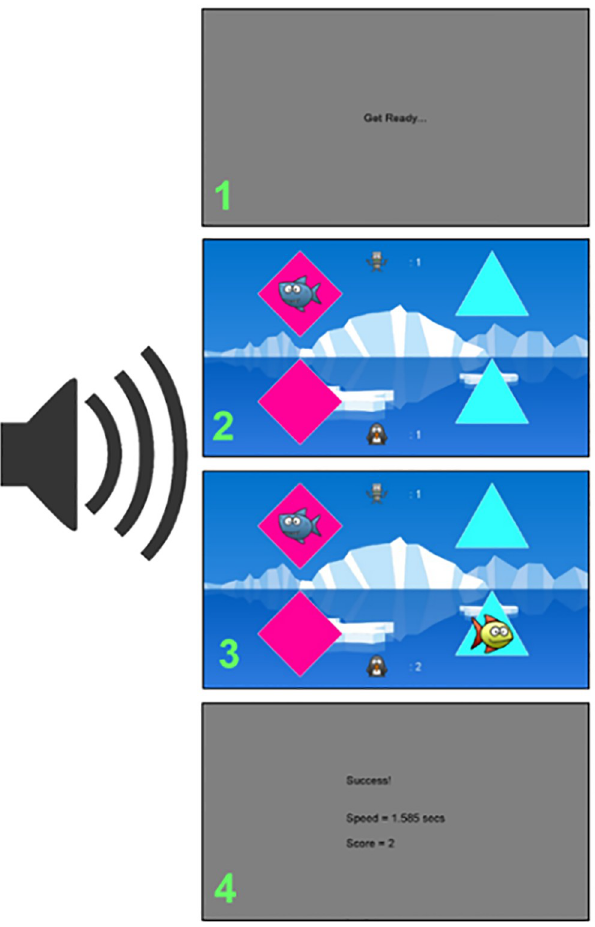
Fig 1. Example trial of the binary choice task being completed with the secondary task. This is an example of an unsuccessful information trial (shark is displayed).